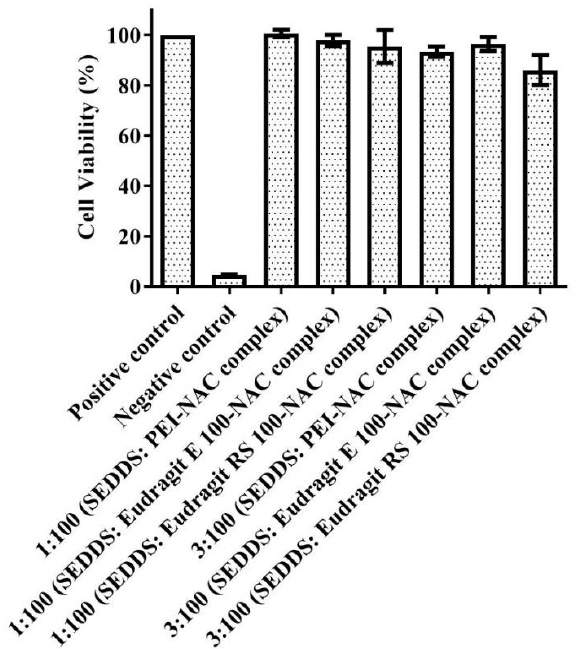
Figure 6. Caco-2 cell viability percentages in the resazurin test following treatment of 1:100 and 3:100 dilutions of the SEDDSs bearing various NAC complex loads in HBS (pH 7.4) after a 4 h incubation period at 37 °C. The data iare provided as the mean ± standard deviation of three experiments.